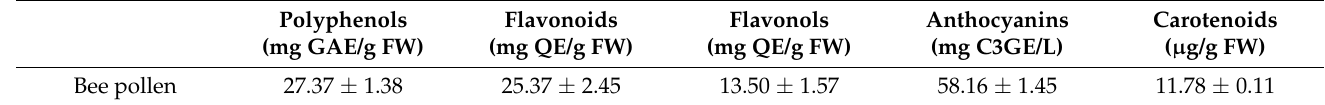
Table 1. Total polyphenol ( λ = 760 nm), flavonoid ( λ = 430 nm), flavonol ( λ = 360 nm), monomeric anthocyanin ( λ = 520 and 700 nm), and carotenoid ( λ = 450 nm) concentration. Results were expressed as mean values ± SD of three